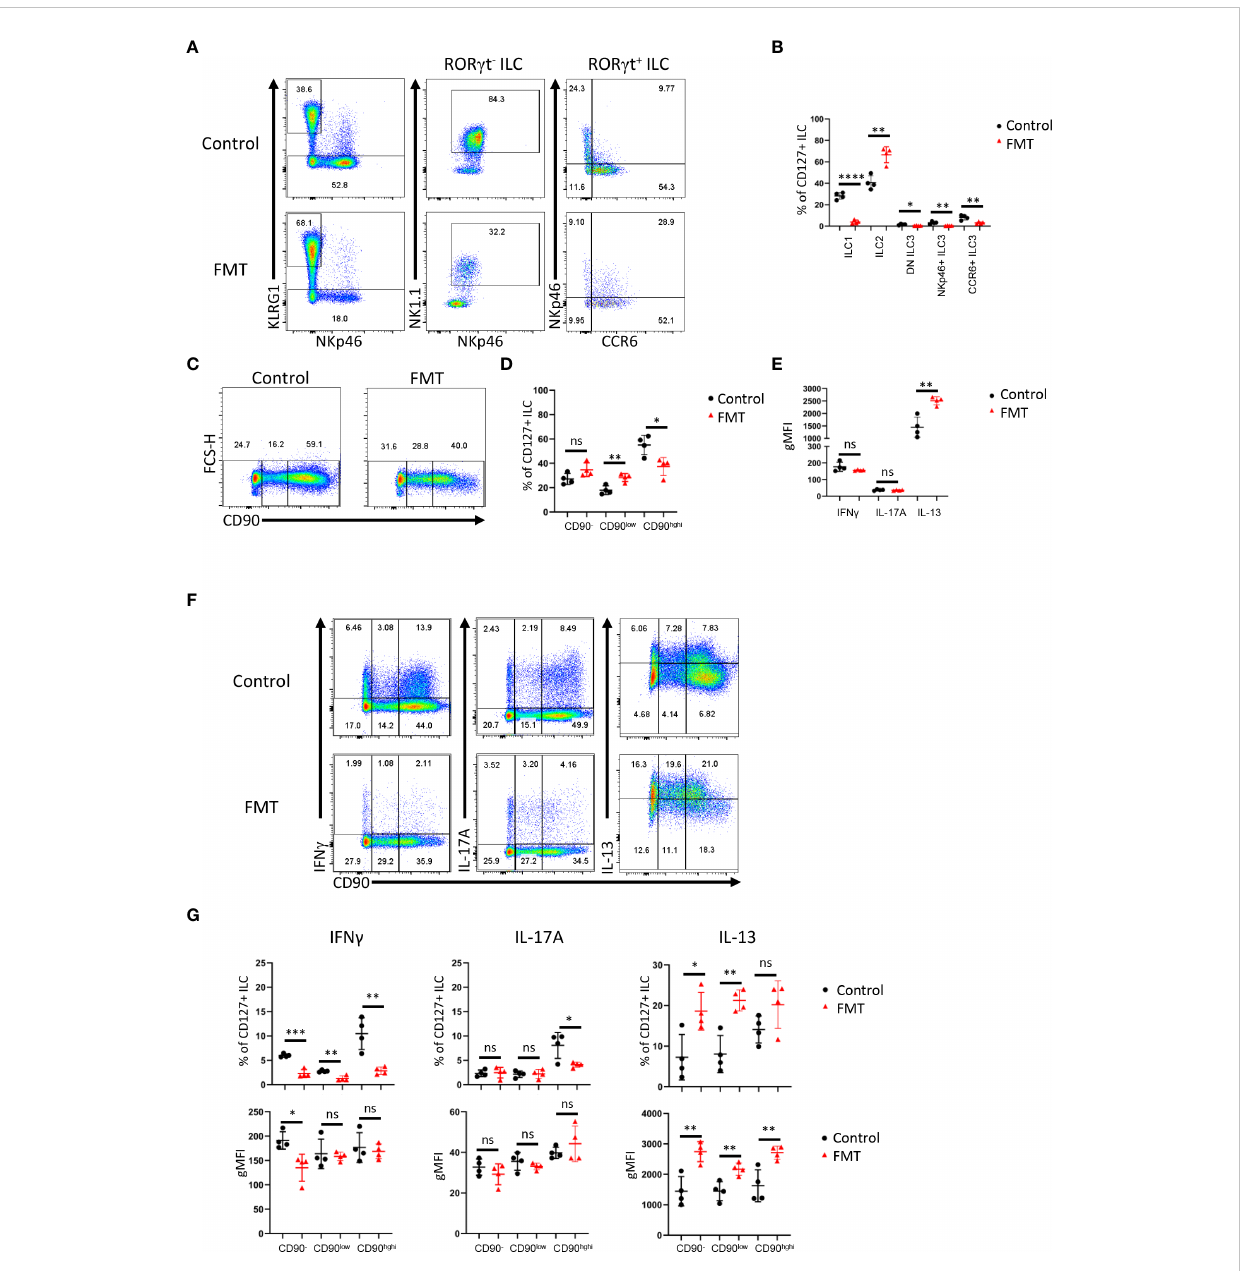
FIGURE 4 Dysbiosis-triggered appearance of functional cLP ILC with a low expression of CD90. Feces from TRUC mice were transferred into Rag2 -/- mice and cLP leukocytes were isolated 21 days later from treated and untreated mice. (A) KLRG1 + ILC2, KLRG1 - ROR g t - NKp46 + NK1.1 + ILC1, KLRG1 - ROR g t + ILC3 subsets from FMT-treated and untreated control mice were analyzed by fl ow cytometry. ILC3 subsets were de fi ned as NKp46 + CCR6 - , CCR6 + NKp46 - or DN ( ‘ double negative ’ ) in these analyses. (B) A statistical analysis of ILC subset frequency among the whole cLP ILC population is outlined. (C) ILC with no or a low or high expression of CD90 were analyzed by fl ow cytometry and (D) a statistical analysis of the frequency of these ILC among the whole ILC population is presented. (E) The per cell expression of IFN g , IL-17A and IL-13 in ILC was analyzed statistically. (F) IFN g , IL-17A and IL-13 expression in CD90 - , CD90 low and CD90 high ILC was determined by fl ow cytometry. (G) Related statistical analyses investigating the frequency of respective ILC and the per cell expression of IFN g , IL-17A and IL-13 in the CD90 - , CD90 low and CD90 high ILC populations are shown. Data are representative of 4 biological replicates. ns, non-signi fi cant; *p < 0.05; **p< 0.01; ***p<0.001;